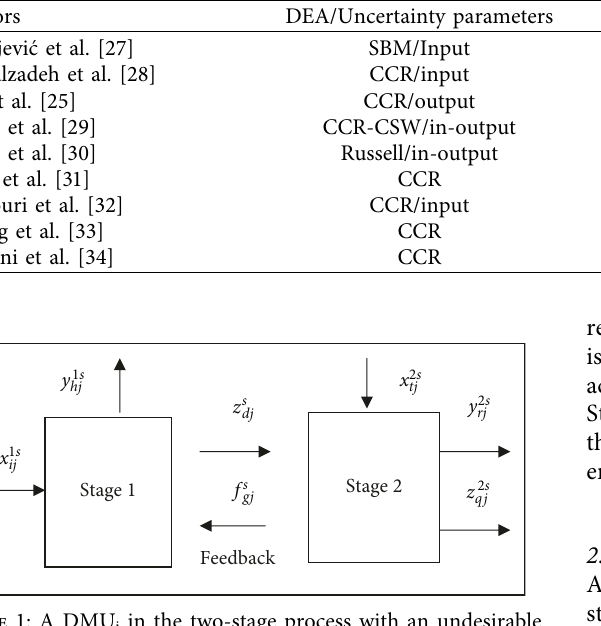
j in the two-stage process with an undesirable